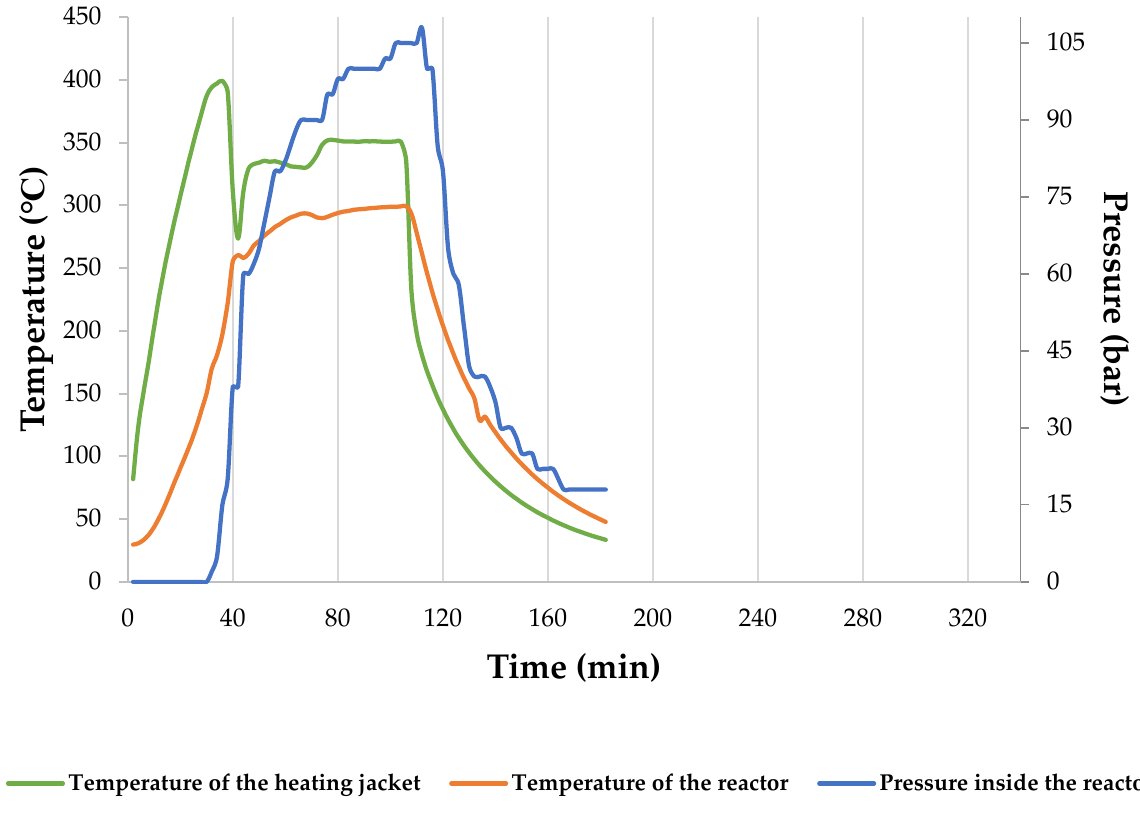
Figure A7. Temperature and pressure patterns during the process at 300 ◦ C in 30 min.